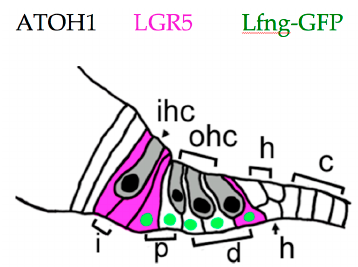
Figure 2. Neonatal cochlear supporting cells. The inner hair cell (ihc) and outer hair cells (ohc) are depicted in gray, with ATOH1 + nuclei in black. Interphalangeal cells (i), pillar cells (p), Deiter cells (d), Hensens cells (h), and Claudius cells (c) are all indicated. LGR5 + (Leucine-rich repeat containing G-protein coupled receptor 5) cells are indicated in magenta, and Lfng-GFP + cells with green nuclei. All supporting cells express SOX2 (Sry-box 2, not shown). See text for references.